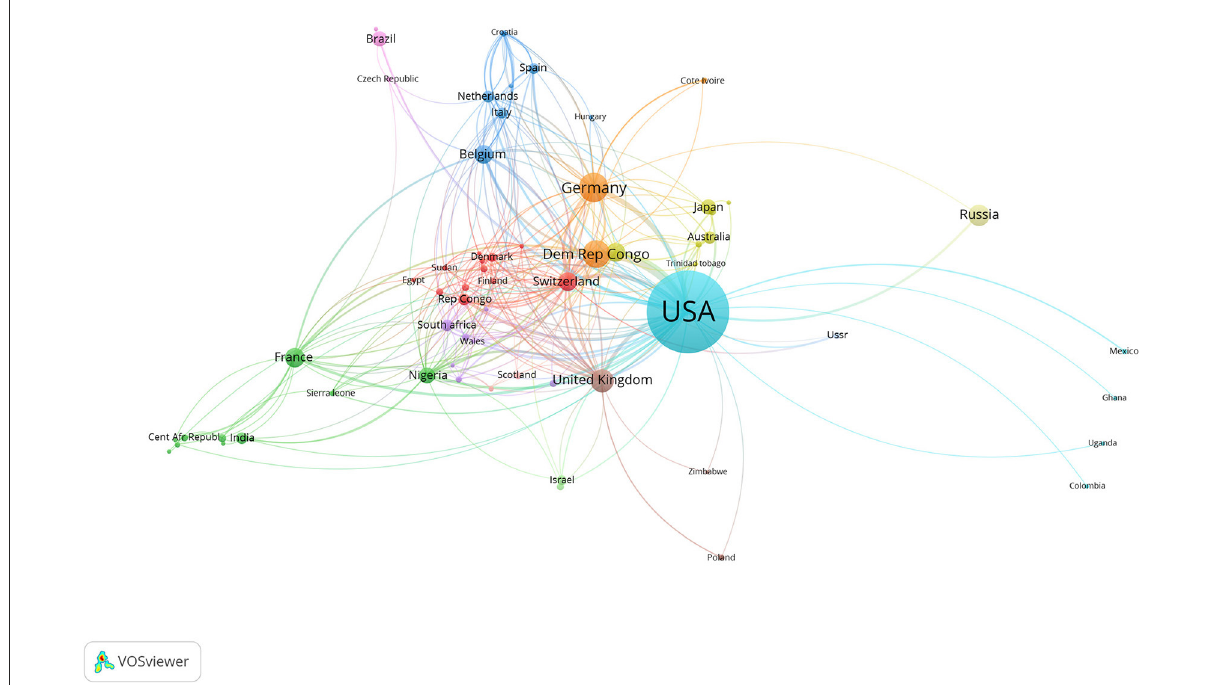
FIGURE7 The distribution of countries or regions in monkeypox research.